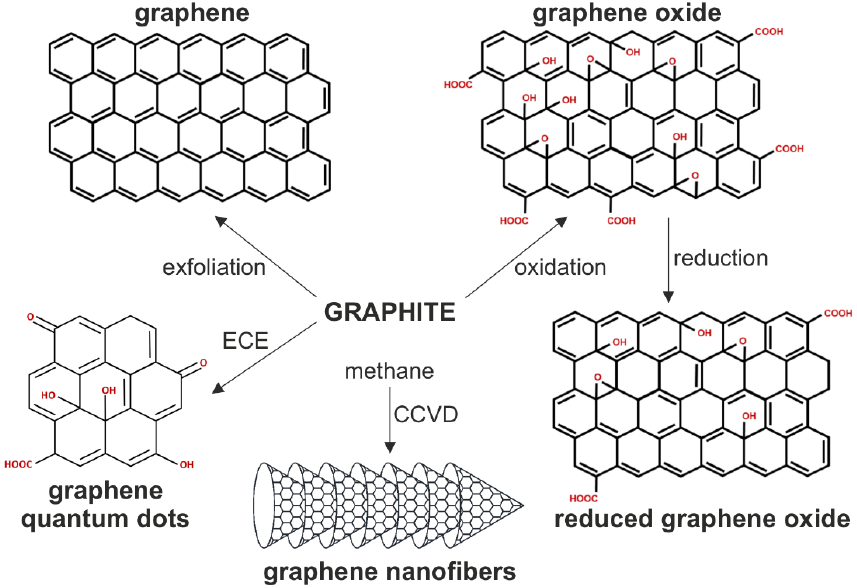
Figure 1. The structure of biologically relevant GNM. The chemical structure of GNM and the main methods for their synthesis are presented. CCVD, catalytic chemical vapor deposition; ECE; electrochemical exfoliation.